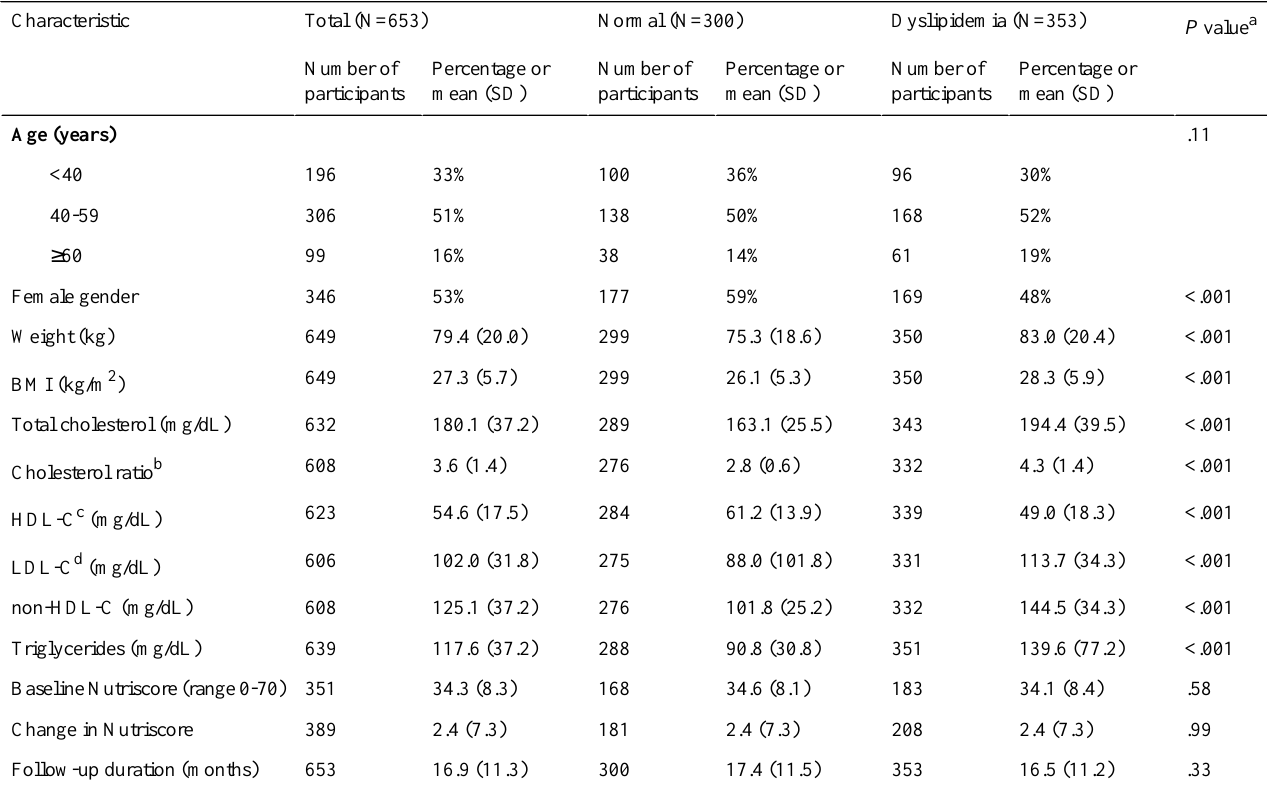
Table 1. Baseline characteristics of the total study sample and those stratified by baseline dyslipidemia